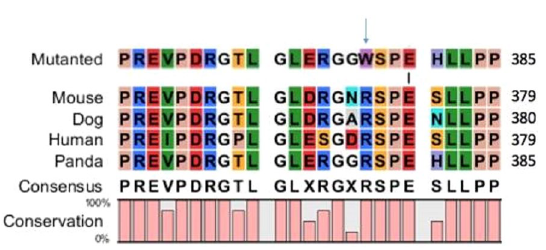
Figure 3. Effect of replacing a highly-conserved arginine residue with tryptophan between the isoform-specific and downstream hydrophobic regions of HSF4. Multiple alignment of a highly-conserved sequence of 25 amino acid residues in four orthologs of HSF4 (mouse, dog, human and panda) showing that the panda R377W substitution affects an arginine residue conserved across all species (equivalent to human residue